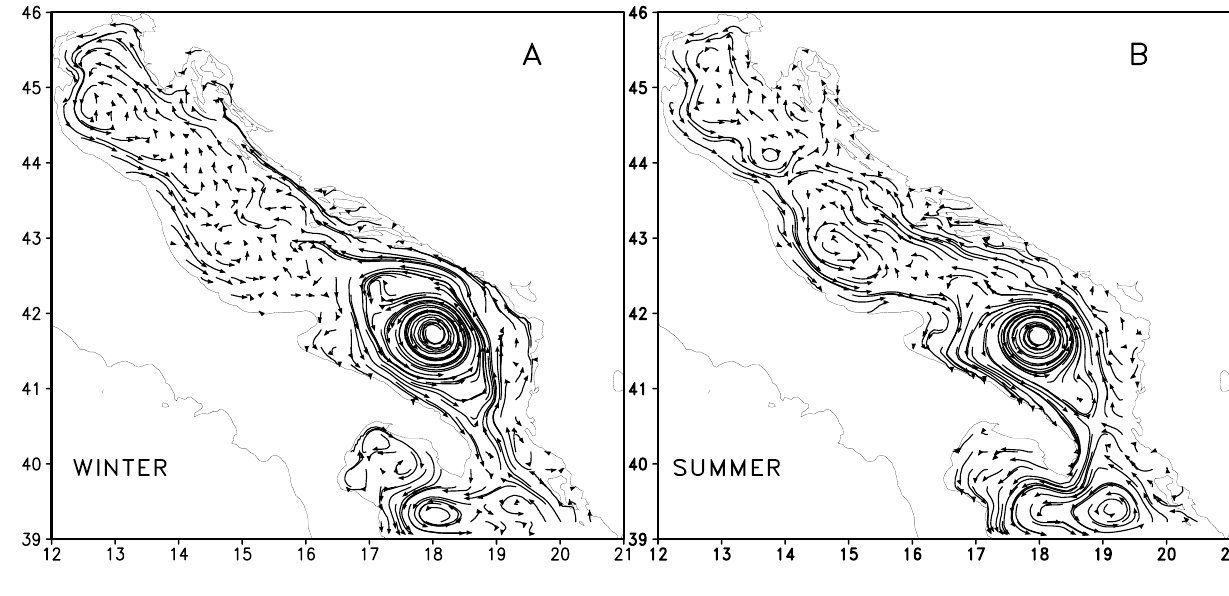
Fig. 5. Adriatic Intermediate Model (AIM). Seasonal velocity trajectories at 2m depth computed as if the flow were steady for 5 days. (A) : winter, (B) : summer. Not all the grid points have been plotted. Seasons definition as in Artegiani et al. (1997a, b).